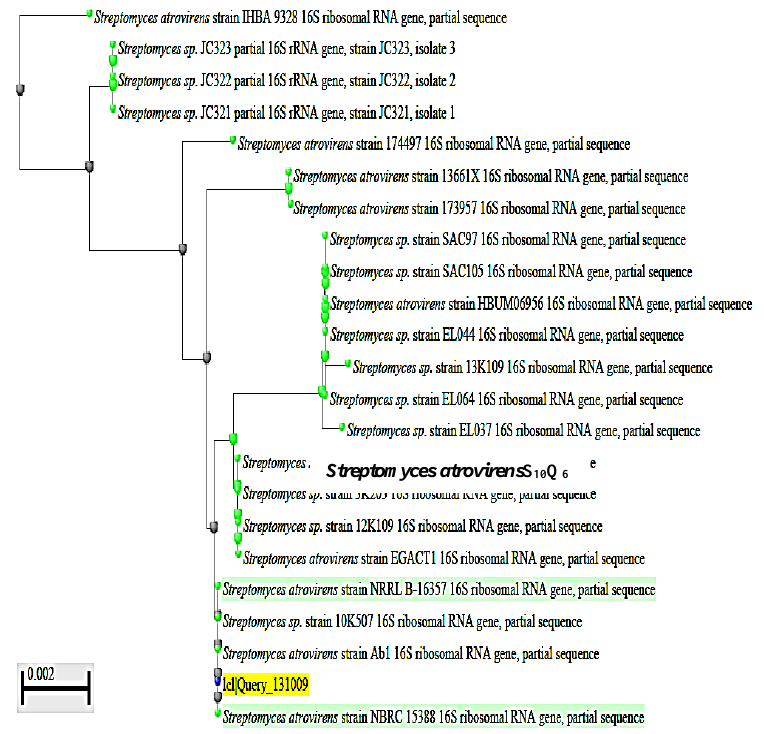
Figure 2. Phylogenetic tree showing the dendrogarm of the clusters analysis of some selected strains